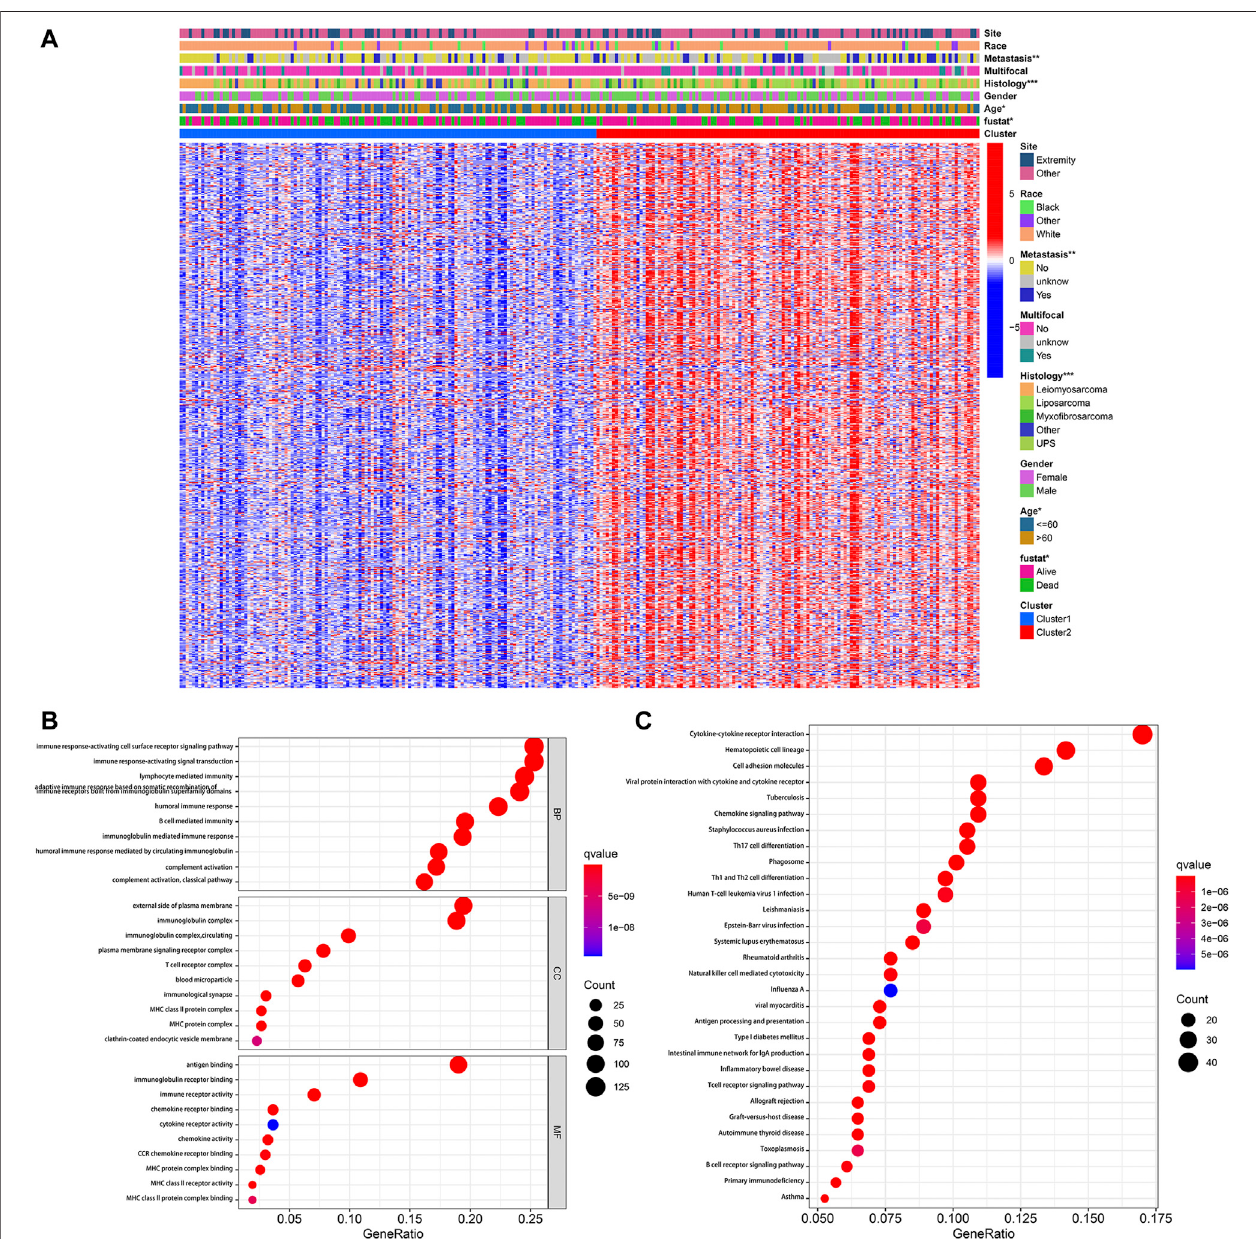
FIGURE 4 | Identi fi cation of DEGs between pyroptosis-related clusters. (A) Heatmap depicting DEGs of pyroptosis-related clusters and corresponding clinical characteristics. (B) GO enrichment analysis including biological process (BP), cellular component (CC), and molecular function (MF). (C) KEGG enrichment analysis indicating related genes and pathways. * p < 0.05, ** p < 0.01, *** p <